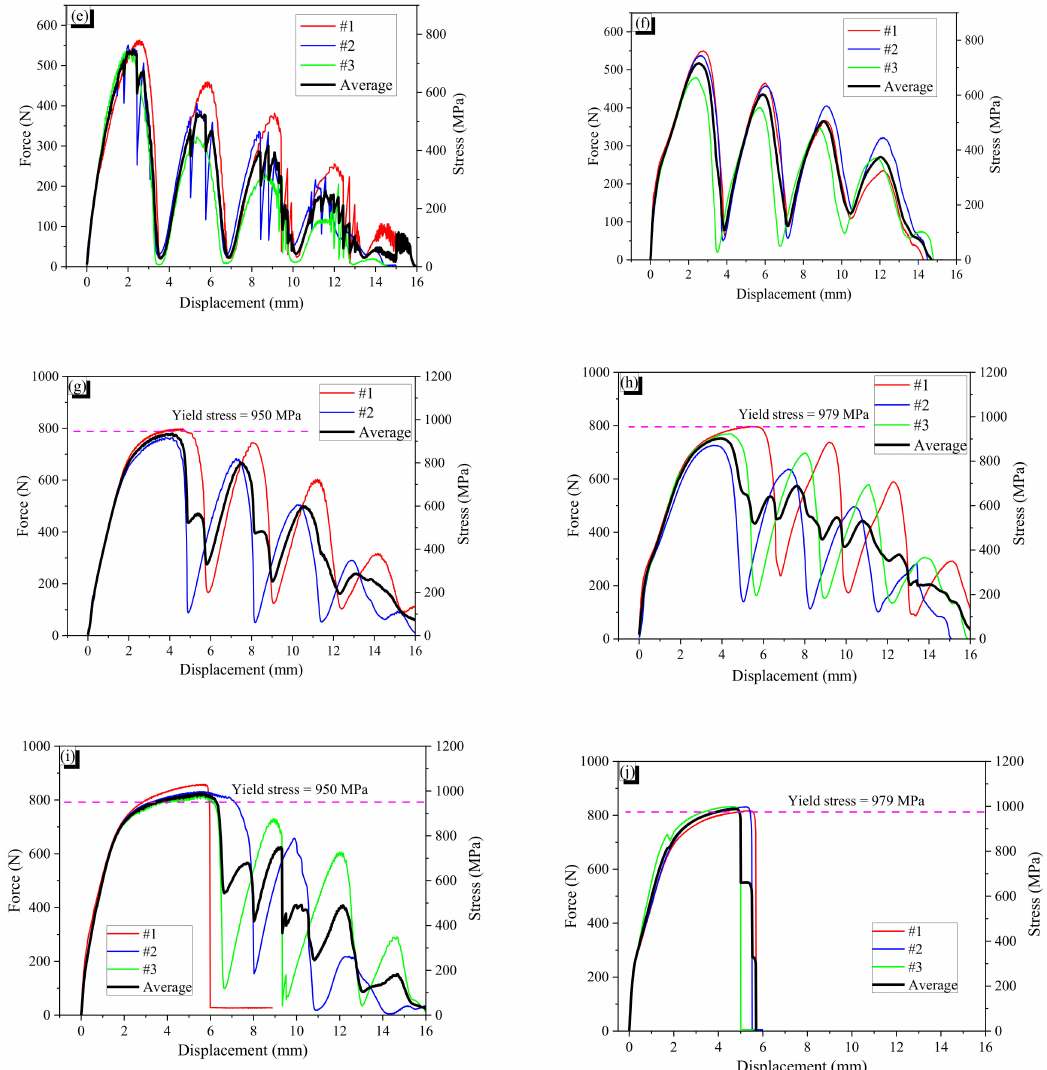
Figure 12. Force–displacement curves of the AR1.0 and CR1.0 fibers: ( a ) AR1.0-N fiber; ( b ) AR1.0-H fiber; ( c ) CR1.0-1N fiber; ( d ) CR1.0-1H fiber; ( e ) CR1.0-2N fiber; ( f ) CR1.0-2H fiber; ( g ) CR1.0-3N fiber; ( h ) CR1.0-3H fiber; ( i ) CR1.0-4N fiber; ( j ) CR1.0-4H fiber. The red, blue, green and black solid curves indicated the force-displacement curves of sample #1, #2, #3 and their average.